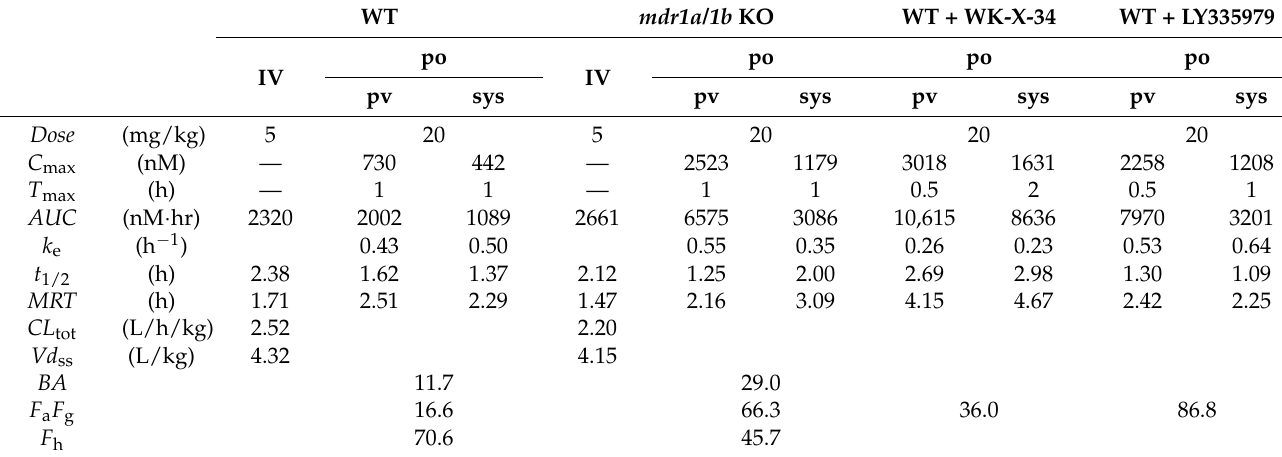
Figure 4. Plasma concentration-time profiles of paclitaxel after intravenous and oral administration with or without WK-X-34 and LY335979 pretreatment in mice. ( A ) Paclitaxel was intravenously injected into WT mice ( ▲ ) and mdr1a/1b KO mice ( ▵ ) at a dose of 5 mg/kg. ( B ) Paclitaxel was orally administered into WT mice and mdr1a/1b KO mice at a dose of 20 mg/kg. ● : portal plasma concentration in WT mice, ■ : systemic plasma concentration in WT mice, ○ : portal plasma con- centration in mdr1a/1b KO mice, and □ : systemic plasma concentration in mdr1a/1b KO mice. (C,D) Paclitaxel was orally administered into WT mice at a dose of 20 mg/kg, pretreated with 40 mg/kg WK-X-34 ( C ) or 60 mg/kg LY335979 ( D ). ● : portal plasma concentration, ■ : systemic plasma concentration. Data are represented as mean ± S.D. ( n = 3). Table 3. Pharmacokinetic parameters of paclitaxel after intravenous and oral administration to wild type (WT) and mdr1a/1b knockout (KO)